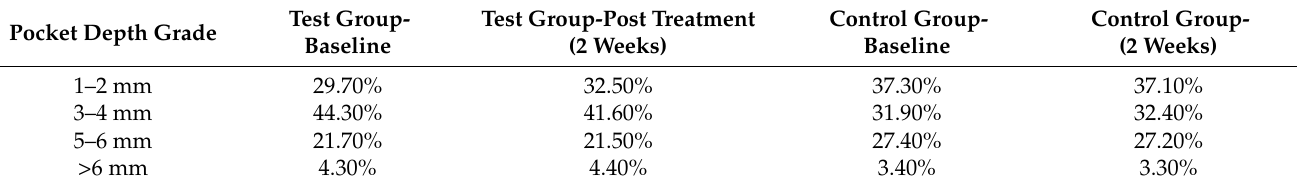
Table 1. Pocket depth assessment of the Test and Control Group at the baseline and after 2 weeks.